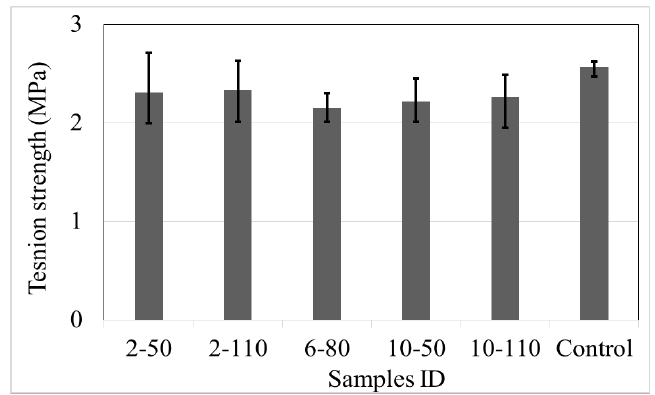
Figure 12. Splitting tensile strength of control samples and concrete with recycled PET fibres.